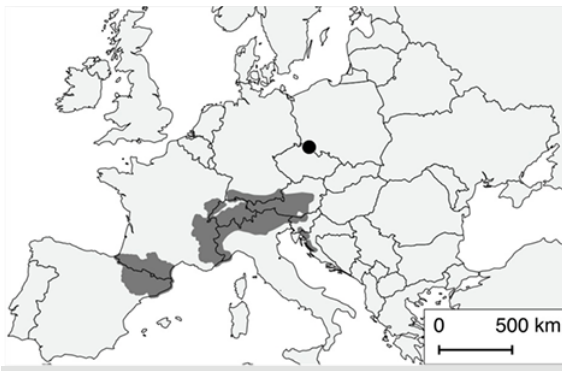
Fig. 1 Location of the population from the Karkonosze Mts (marked with the black dot) with the whole distribution range of Rhododendron ferrugineum in Europe indicated in dark gray (from Khela